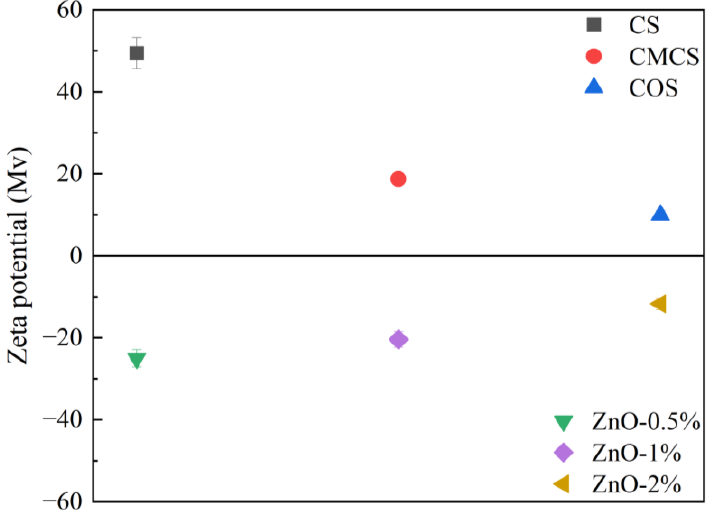
Figure 1. Zeta potentials of chitosan (CS), carboxymethyl chitosan (CMCS), and chitosan oligosaccharide (COS), with ZnO (0.5%, 1%, and 2%).